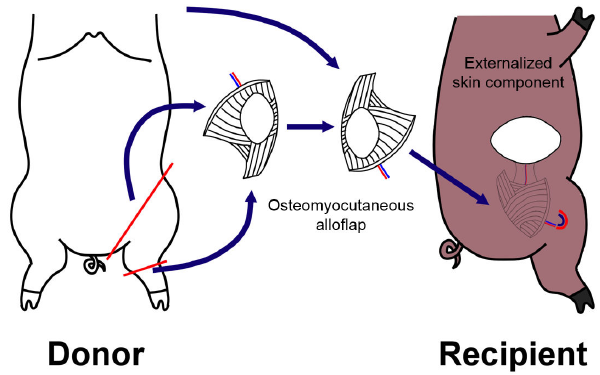
Figure 1. Schematic diagram of swine heterotopic hind limb transplant. Osteomyocutaneous flap consisting of femur, tibia, fibula, knee joint, overlying muscles and skin is transplanted to a subcutaneous pocket in recipient with externalized skin